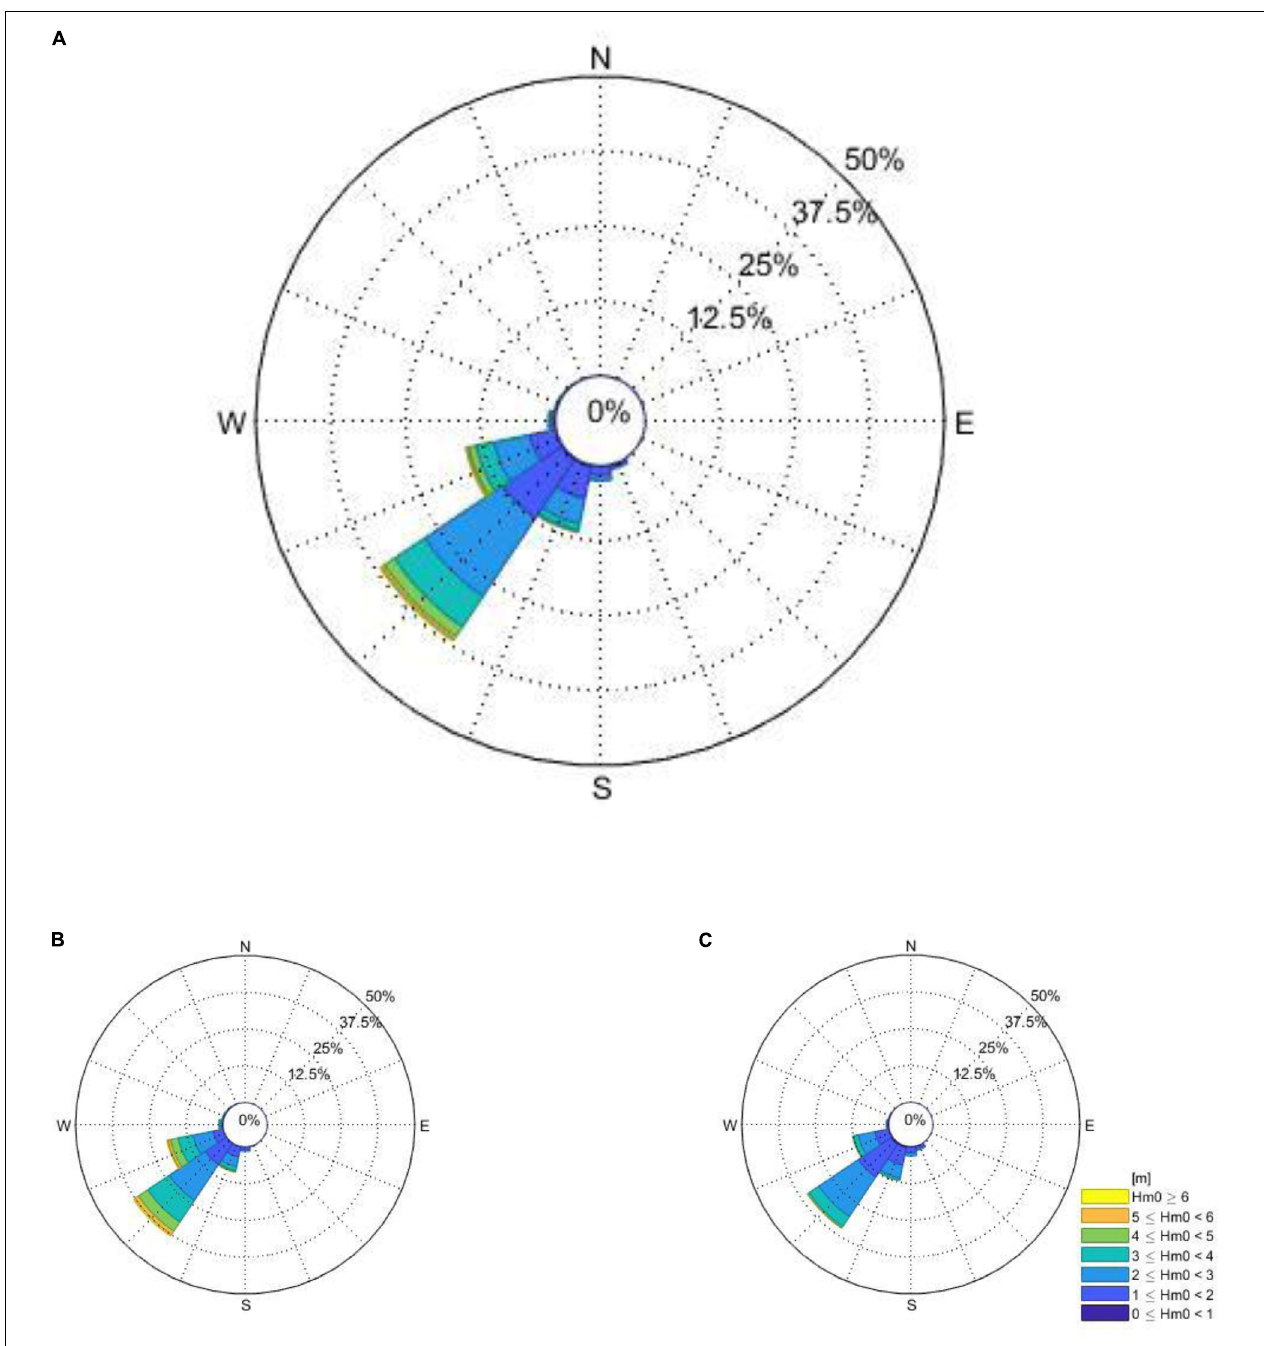
FIGURE A1 | The total and seasonal wave roses of the directional wave buoy just offshore from Cape Town is given for years 2000 till end of 2017 (the period for which the directional wave spectra was available). The total (A) , Austral winter (B) , and Austral summer (C) are presented, respectively.